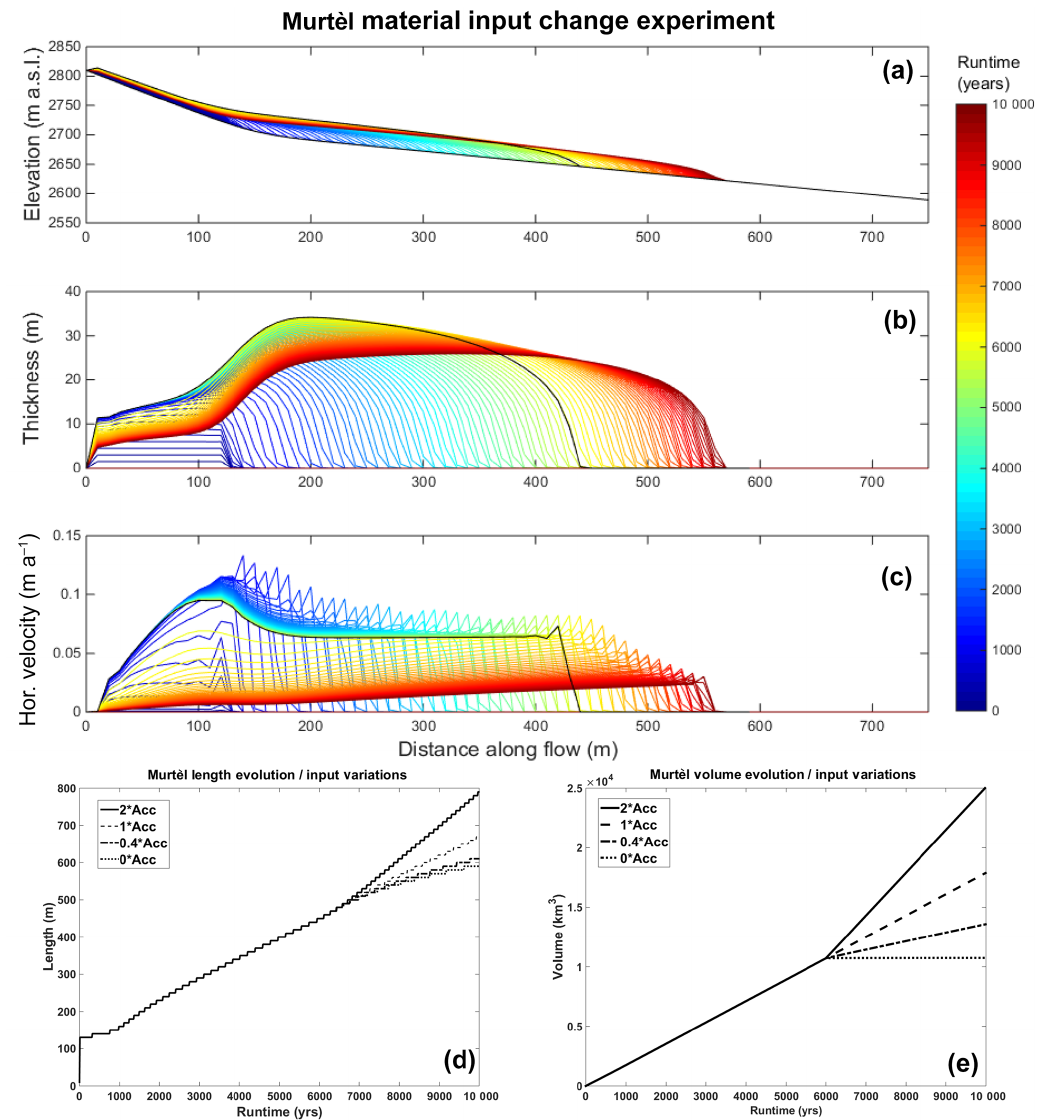
Figure 7. Modeled evolution of surface geometry (a) , absolute thickness (b) , horizontal velocity (c) along the central flow line, terminus advance (d) and volume evolution (e) for Murtèl rock glacier when the material input is switched off at 6000a, after the rock glacier buildup ( − 1.5 ◦ C rock glacier temperature). The black line shows the state of the system before the switch-off of material supply at 6000a. The lines are plotted at 100a time